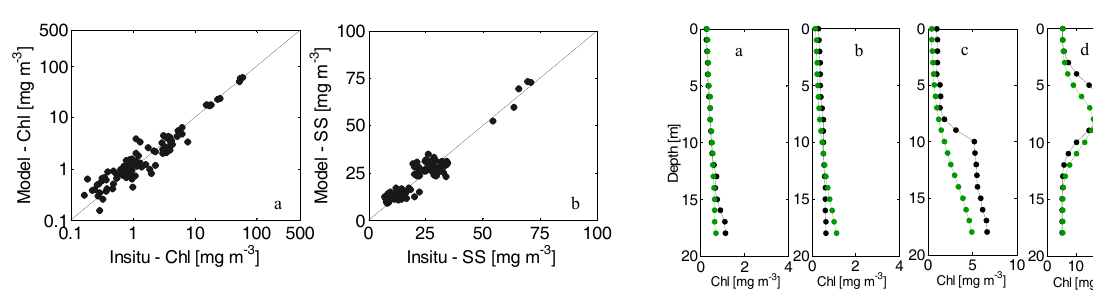
Figure 6. (a) Scatter plot showing the comparison of the estimated chlorophyll concentration from the remote-sensing reflectance R rs with the in situ chlorophyll from different waters. (b) Scatter plot showing the comparison of the estimated suspended sediment con- centration from the remote-sensing reflectance R rs with the in situ suspended sediment concentration from different waters.